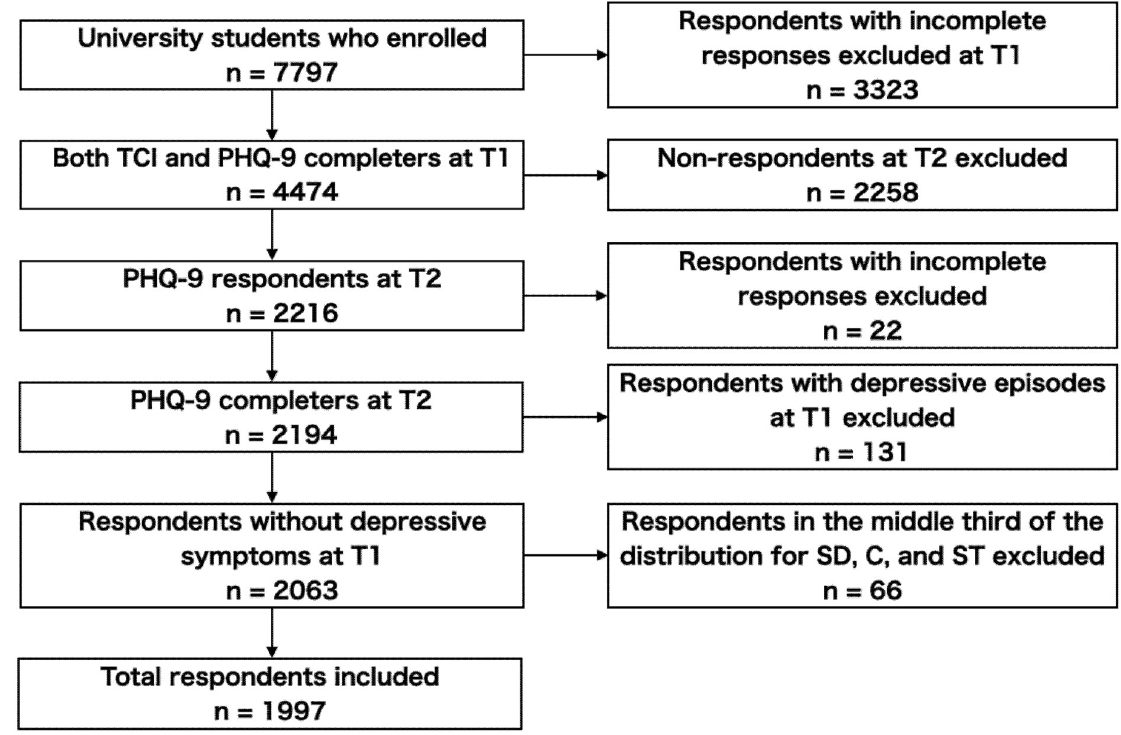
Fig 1. Participant flow. C, cooperativeness; PHQ-9, Patient Health Questionnaire-9; SD, self-directedness; SI, suicide-related ideation; ST, self-transcendence; T1, the time students enrolled at university; T2, three years after enrolment; TCI, Temperament and Character